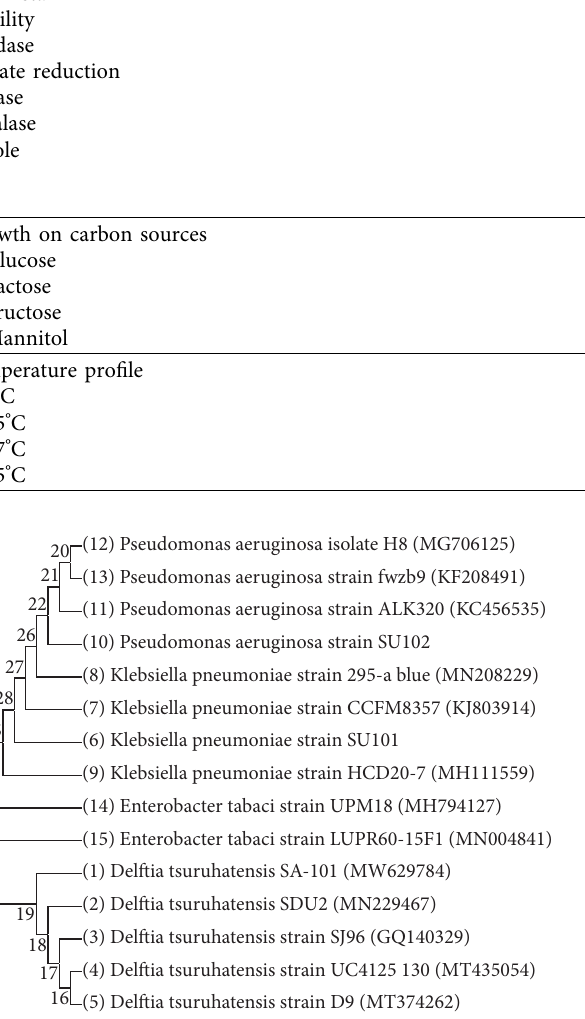
Figure 1: Phylogenetic tree of D. tsuruhatensis SA-101 with its related bacterial species in GenBank database.